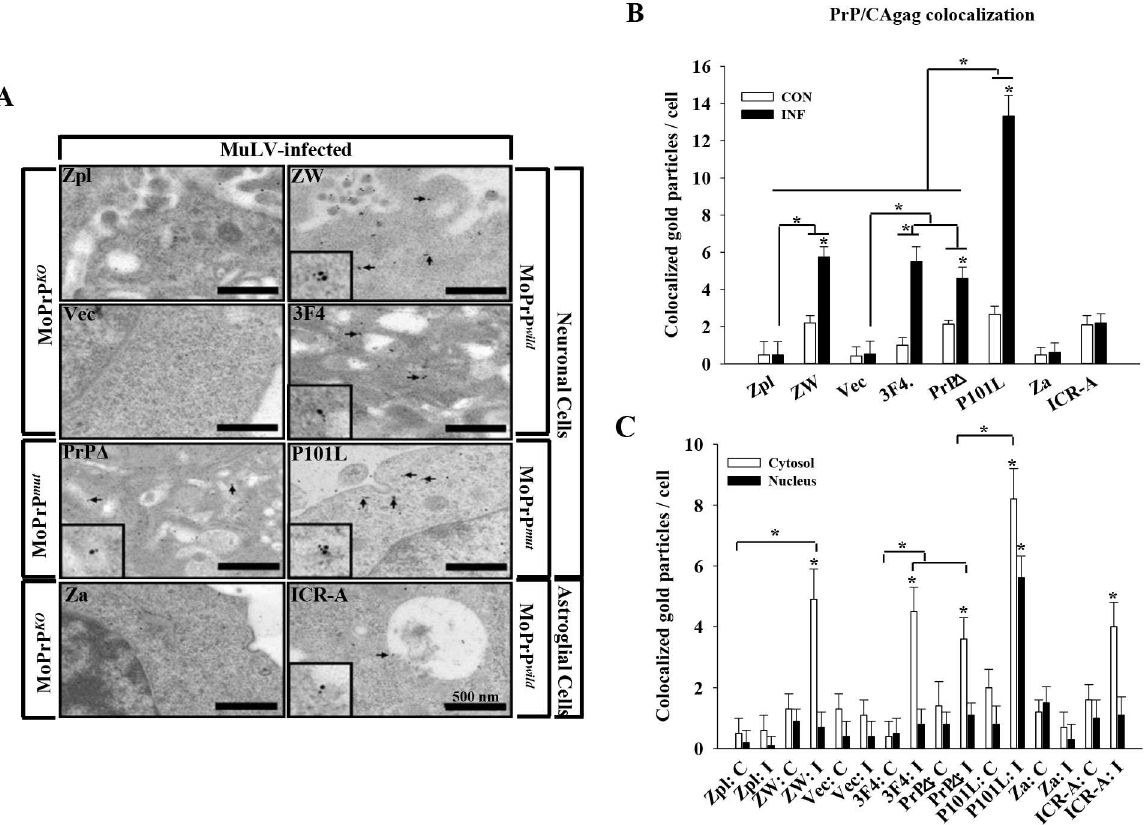
Fig 4. Colocalization of PrP C and CAgag proteins in MuLV-infected cells. (A) Cells infected with MuLV were labeledwith immunogold particles to observecolocalization of PrP C and MuLV using electronmicroscopy. PrP C and MuLV were conjugated with 10 nm-goldparticle and 15 nm-gold particle, respectively.Particles due to colocalization were not observedin PrP -/- cells, regardlessof the cell type. In PrP +/+ neuronalcells, ZW, 3F4, PrP Δ , and P101L, PrP C -CAgagcolocalization was easily observed, whereas colocalization was very rare in PrP +/+ astroglial cells, ICR-A. Black arrows indicate the colocaloization of PrP C and CAgag. Scale bar = 500 nm. (B, C) Quantitationof the experiment shown in (A). Colocalization was assessedin wholesections (B) and in nuclearand cytosol fractions separately (C) by counting the pairedimmunogold particles. PrP +/+ neuronalcells showedmarkedly highernumbers of pairingsof PrP C -CAgag goldparticles comparedto PrP -/- cells and non-infected cells ( * p < 0.001). Particles in the latter 2 groups were non-specificdeposits. P101L PrP +/+ cells had significantly more PrP C -CAgaggold particles pairingsthan other PrP +/+ neuronal cells, ZW, 3F4, and PrP Δ ( * p < 0.001). The small number of particlesseen in PrP -/- cells are background immunogold